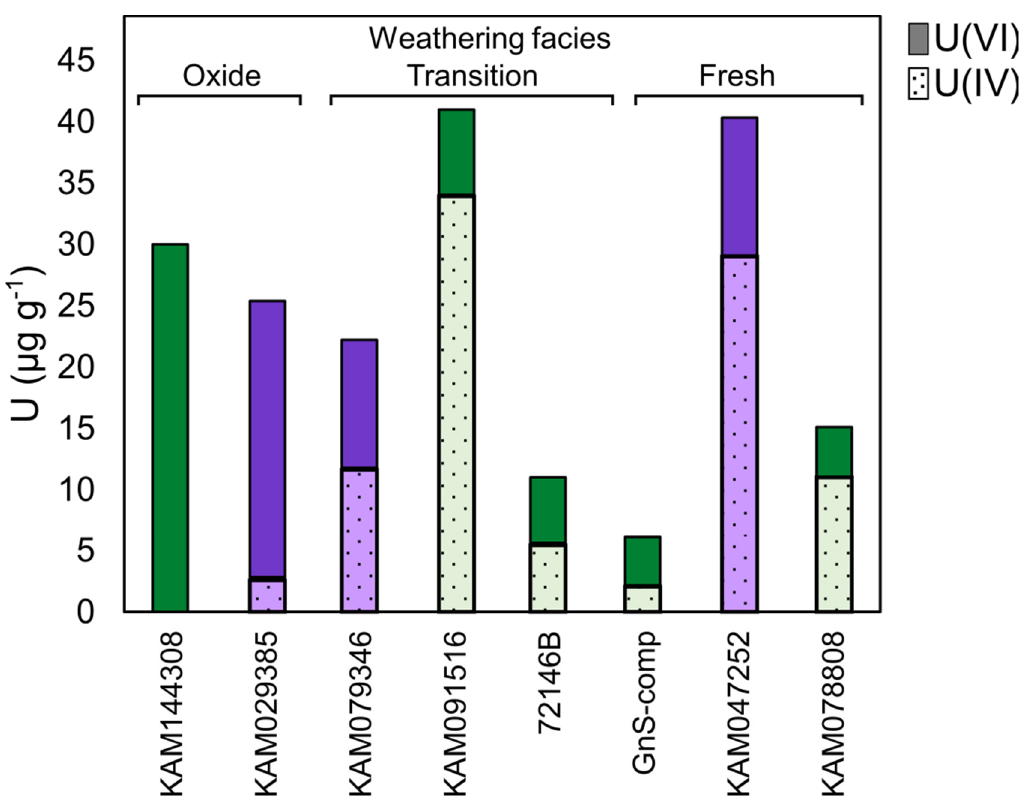
Figure 3. Uranium redox speciation in select Coffee drill-core samples determined by XANES-LCF. Solid fill = U(VI); hatched fill = U(IV); green = gneiss; purple = schist. Full LCF model results and quality of LCF fits (R-factor) are presented in Supplementary Table S3. The LCF error is estimated at ±10%.